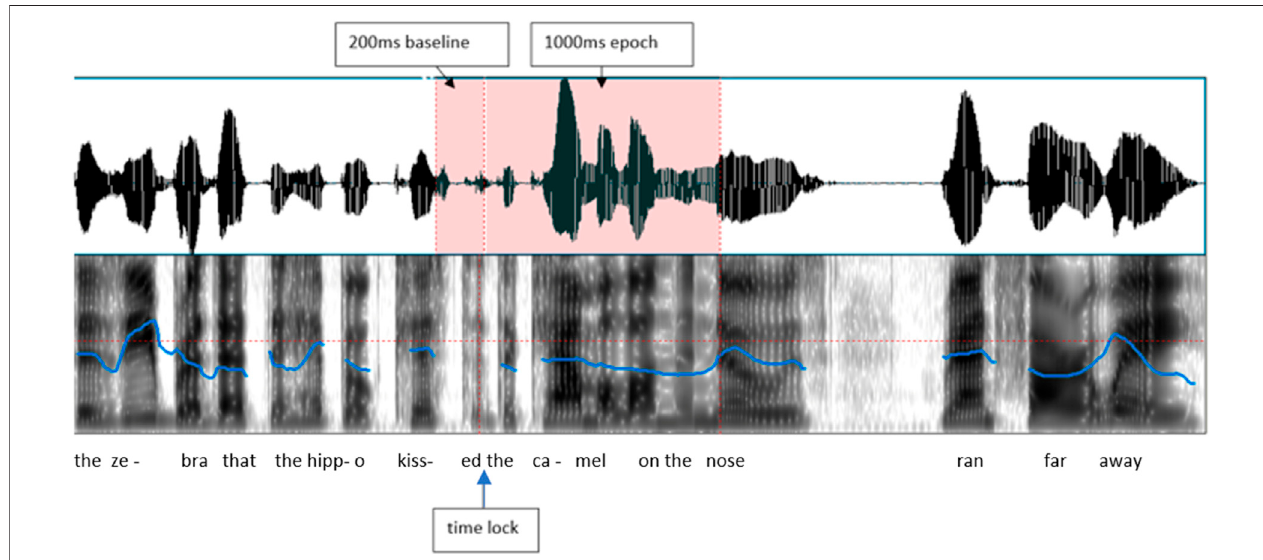
FIGURE 2 | A stimulus sentence example, indicating where the EEG was measured from (between offset of verb and onset of the article “ the ” , and the baseline period.